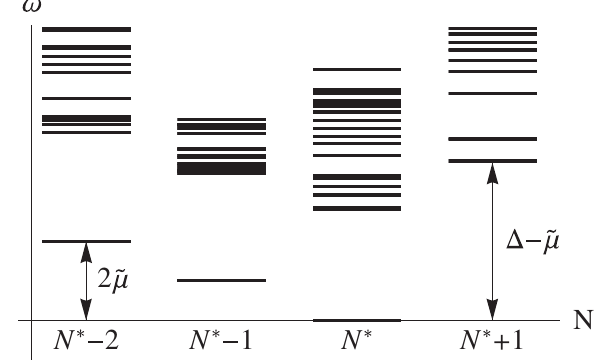
FIG. 2. Generic level diagram of lowest Landau level bosons interacting through a repulsive contact interaction, governed by the Hamiltonian H [Eq. (1)]. If the contact interaction is a P ( k þ 1 )-body term, the system is gapless and degenerate until N ¼ N (cid:2) ≡ kN ϕ = 2 , at which point the exact ground state is a Read-Rezayi state of level k [41]. For all N < N (cid:2) , particles can always be added at a lowest Landau level energy of exactly − ~ μ , but for N > N (cid:2) , the lowest energy state is at least the gap energy Δ (which scales as the smaller of the hopping J and the interaction energy U ) above − ~ μ N . This is simply the state- k þ 1 ment that the fractional quantum Hall state accommodates exactly N (cid:2) particles in its ground state and additional particles added then must go above the many-body gap. That hole states are massively degenerate and isoenergetic reflects the fact that the anyonic quasiholes are dispersionless and noninteracting, and thus do not fractionalize on their own after being created locally through a single-photon loss. Noninteracting topological defects are not a generic feature of most anyon systems, and the lack of inter- actions allows us to induce self-stabilization of the correlated states through the shadow lattice